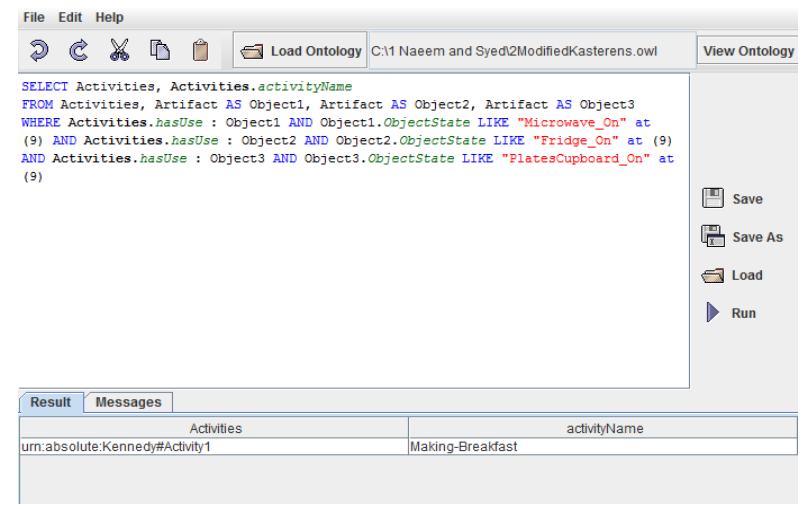
Figure 7. Activity Recognition implementation from an object based query.